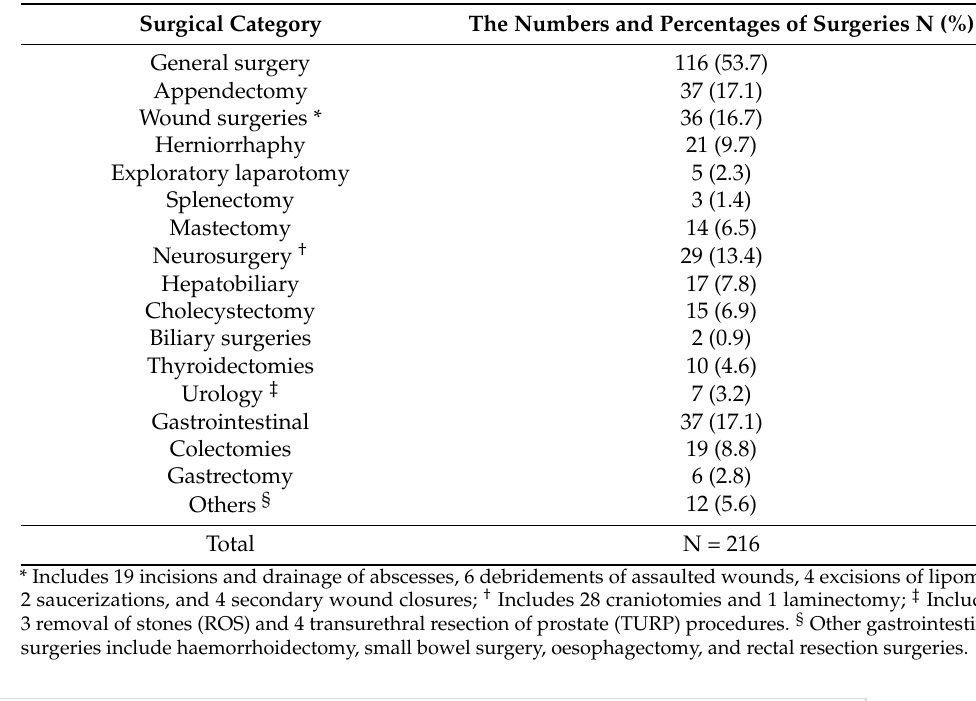
Table 2. The numbers and percentages of surgeries.